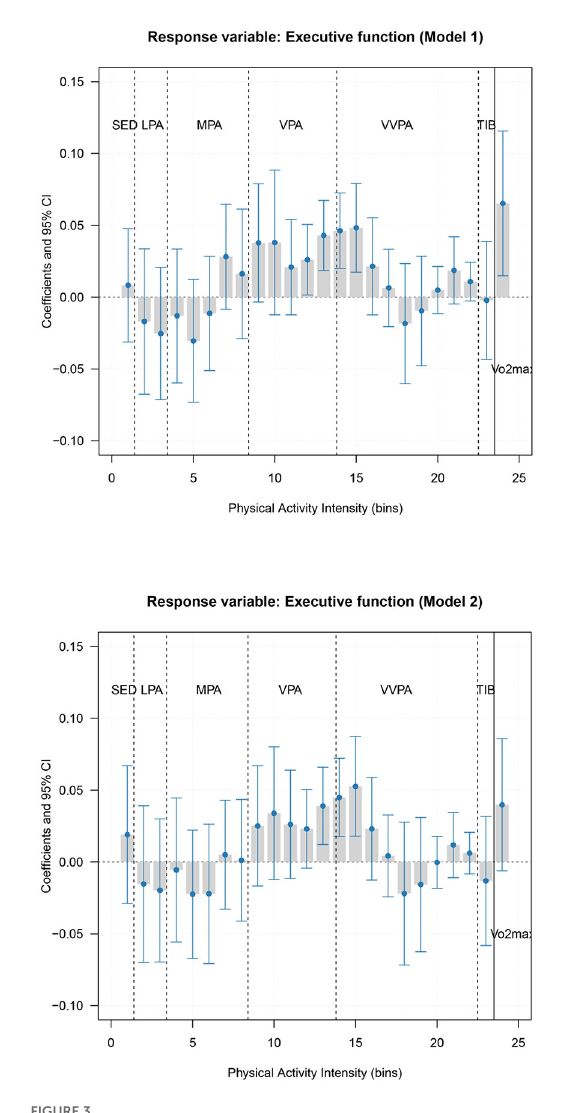
FIGURE4 Association of physical activity intensity variable (bin) and cardiorespiratory fitness with the executive function composite score by fitness level. The last bar marked with Vo2max reflects the association between cardiorespiratory fitness and executive function. We applied gender-specific cut-off value of cardiorespiratory fitness to categorize our participants into high-fit (men: Vo2max > 44.56 mL/kg × min; women: Vo2max > 37.69 mL/kg × min; n = 143) and low-fit